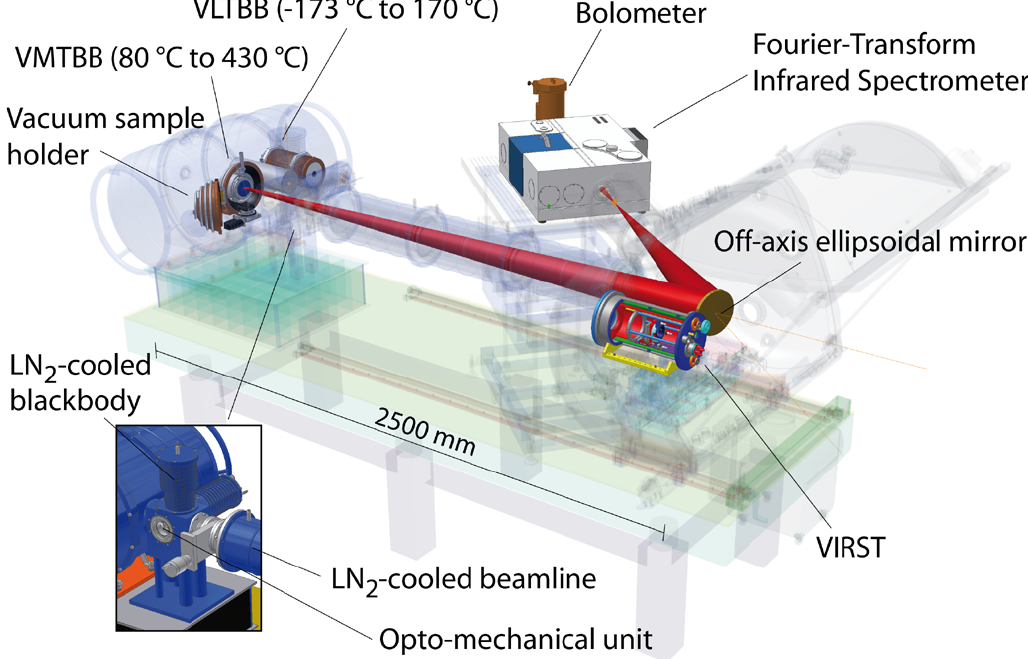
Fig. 5. Transparent view of the Reduced Background Calibration Facility to illustrate the position of the source chamber with the reference blackbodies VLTBB and VMTBB as well as the vacuum sample holder for emissivity measurements; the position of the opto-mechanical unit, with the folding mirrors, the chopper and the liquid-nitrogen-cooled reference blackbody; the position of the beam line; and the position of the detector chamber with the radiation thermometer VIRST and an ellipsoidal mirror guiding the radiation into a Fourier transform spectrometer.